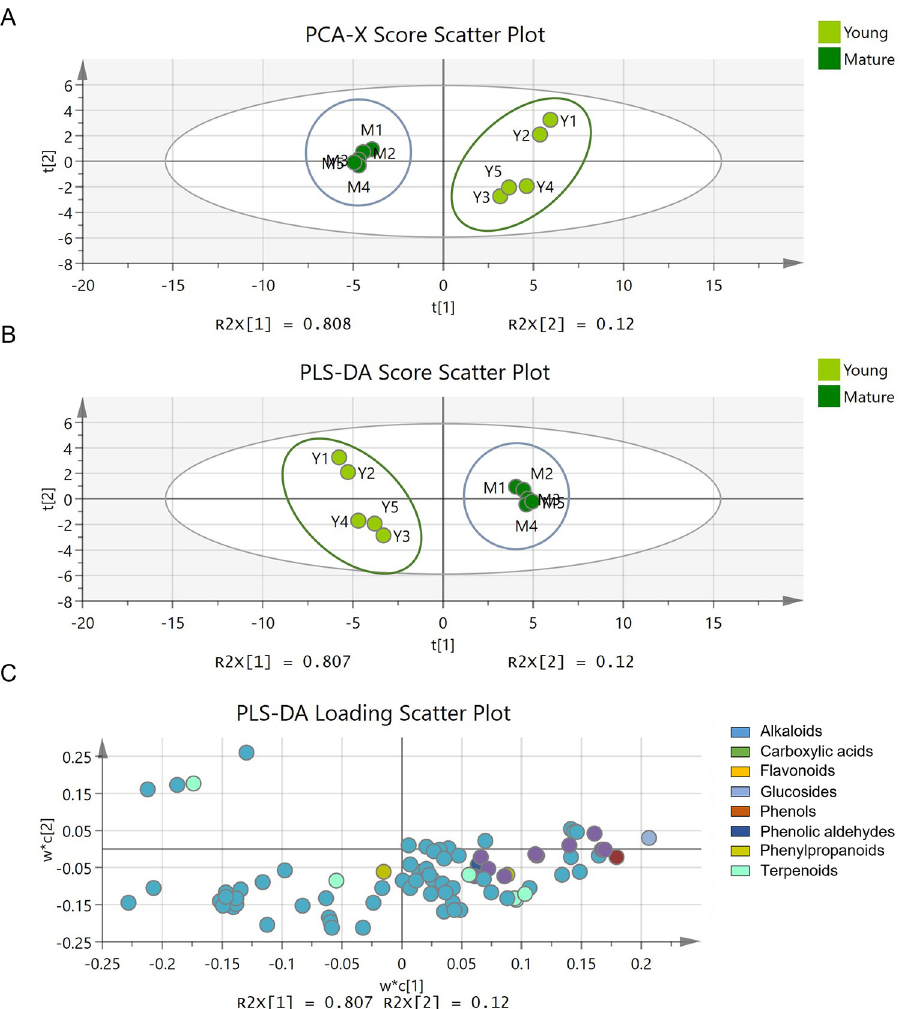
Fig 3. Multivariate analysis of M . speciosa ’s metabolite profile. (A) PCA score scatter plot of young (lime green) and mature (dark green) leaves in five biological replicates. Circles are labelled relative to the leaf age groups. (B) PLS-DA score scatter plot of young and mature leaves in five biological replicates. Circles are labelled relative to the leaf age groups. (C) PLS-DA loading scatter plot projecting metabolite features that influenced the clustering and separation of young and mature leaf